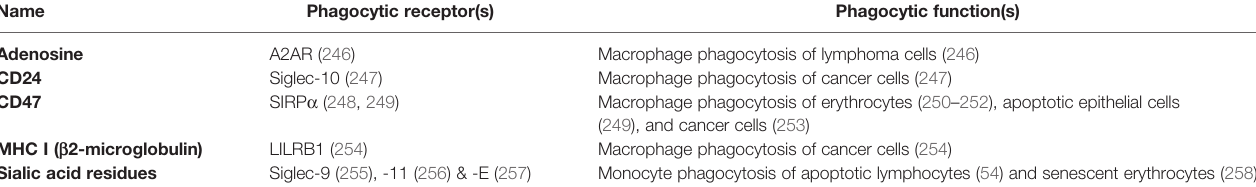
TABLE 4 | Don ’ t-eat-me signals.